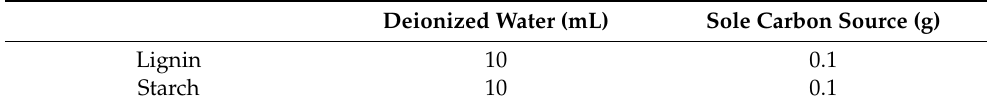
Table 1. Screening media